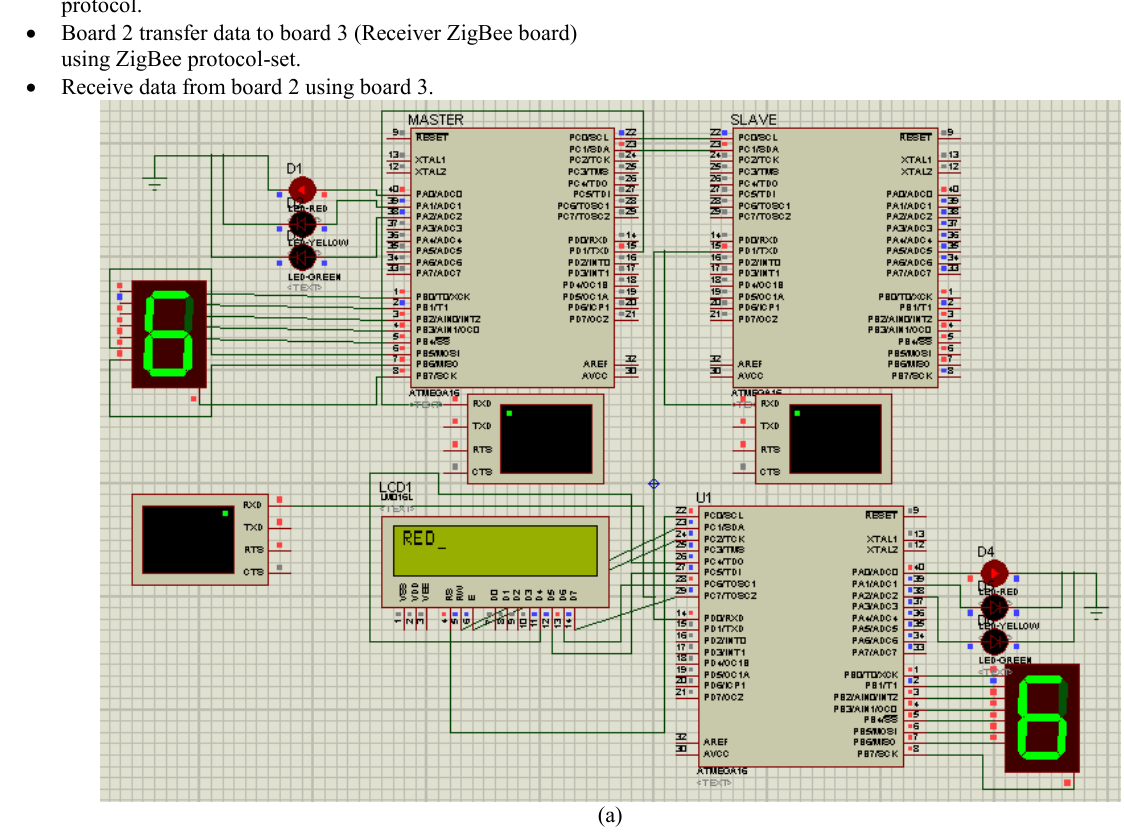
Board 2 transfer data to board 3 (Receiver ZigBee